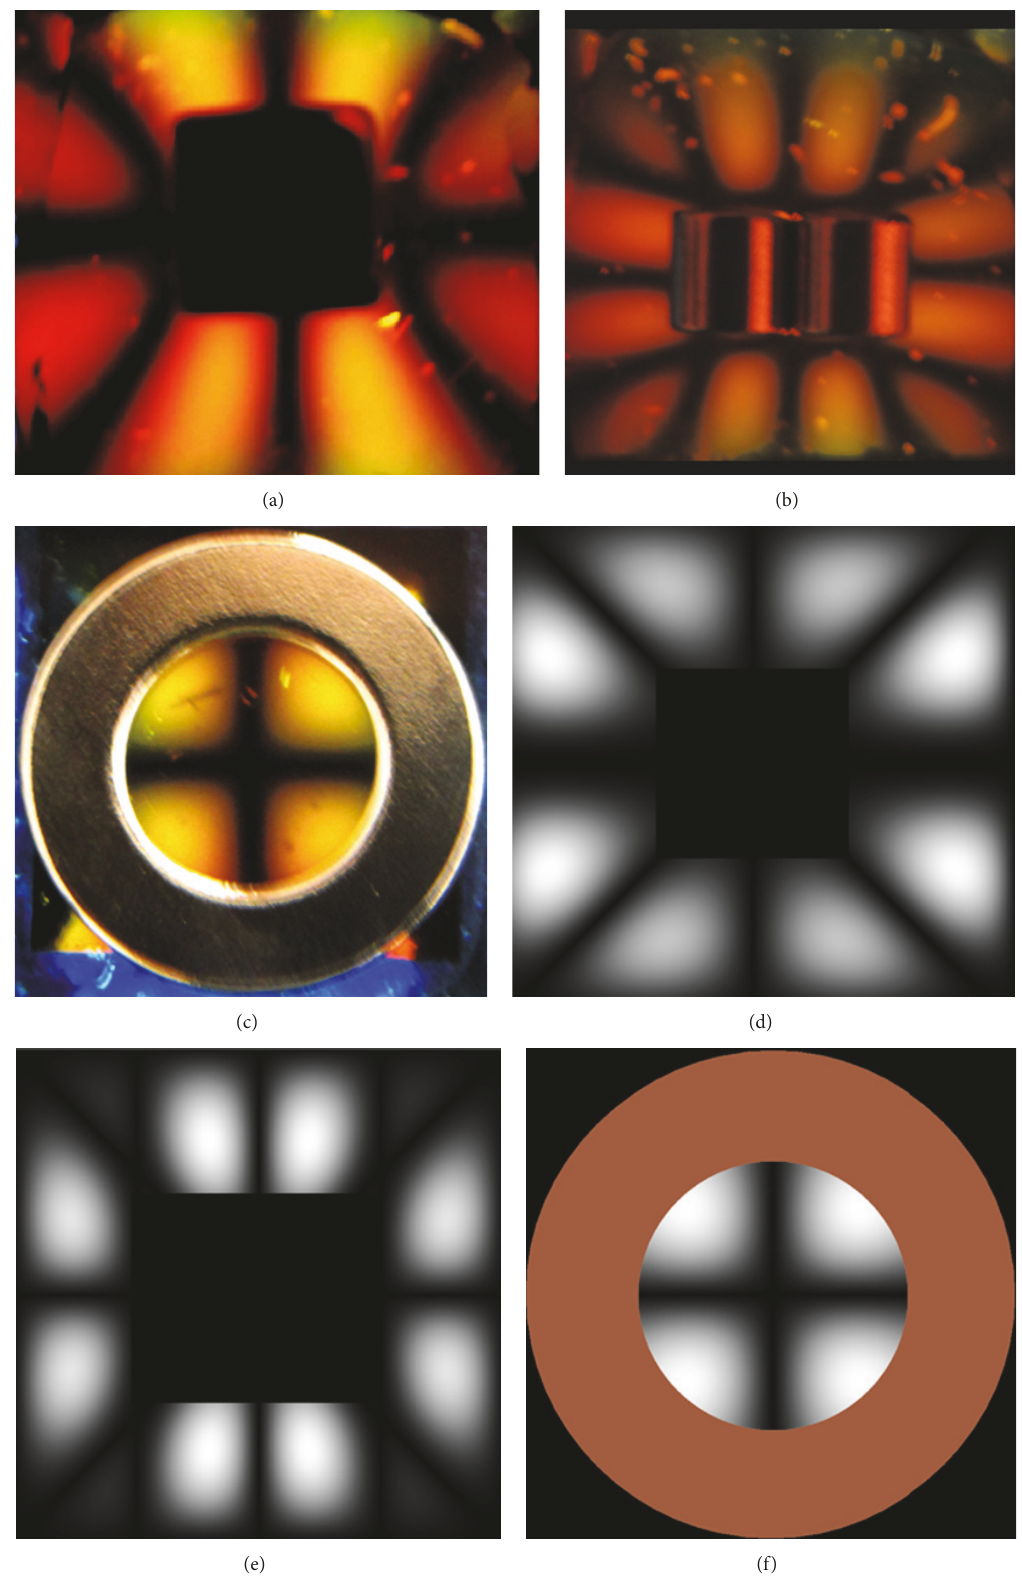
Figure 5: Patterns obtained with bipolar configuration (a); (b) tetrapolar configuration; (c) using a magnetic ring. Simulations for bipolar configuration (d); (e) tetrapolar configuration; (f) for the case of the magnetic